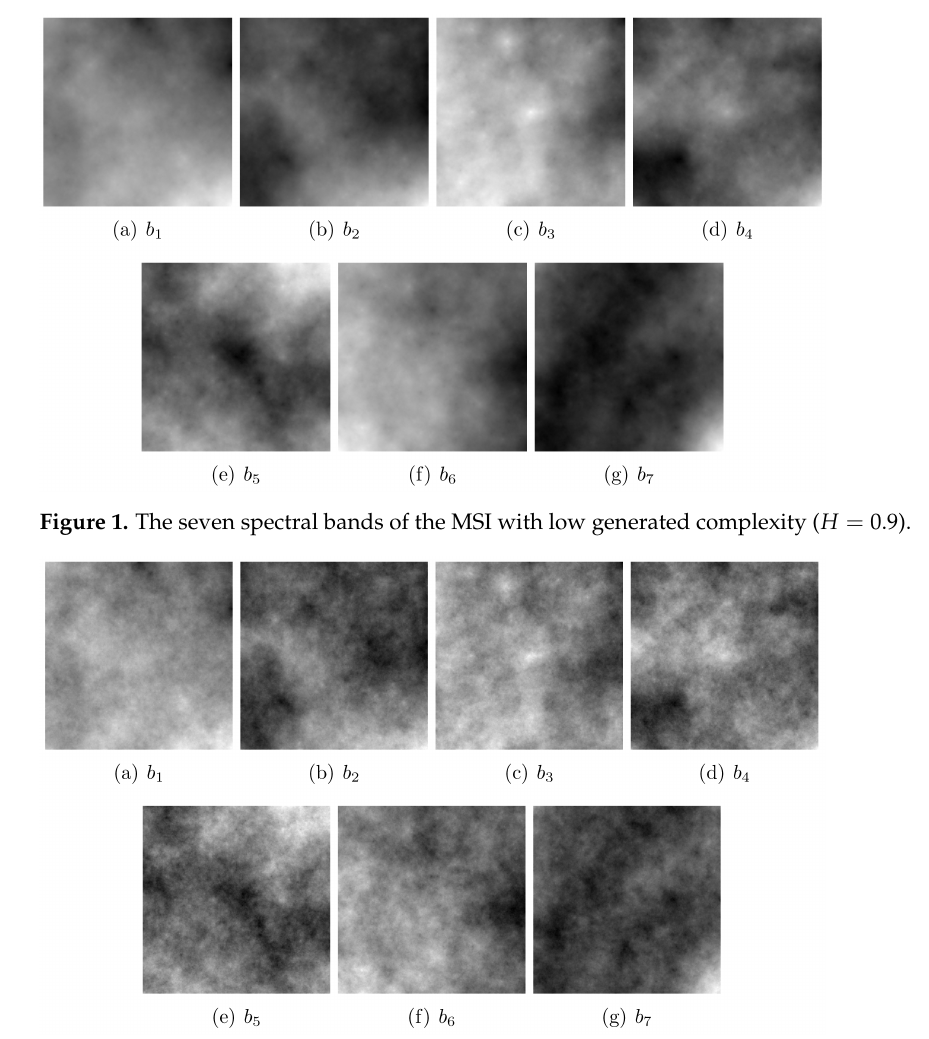
Figure 2. The seven spectral bands of the MSI with medium generated complexity ( H =